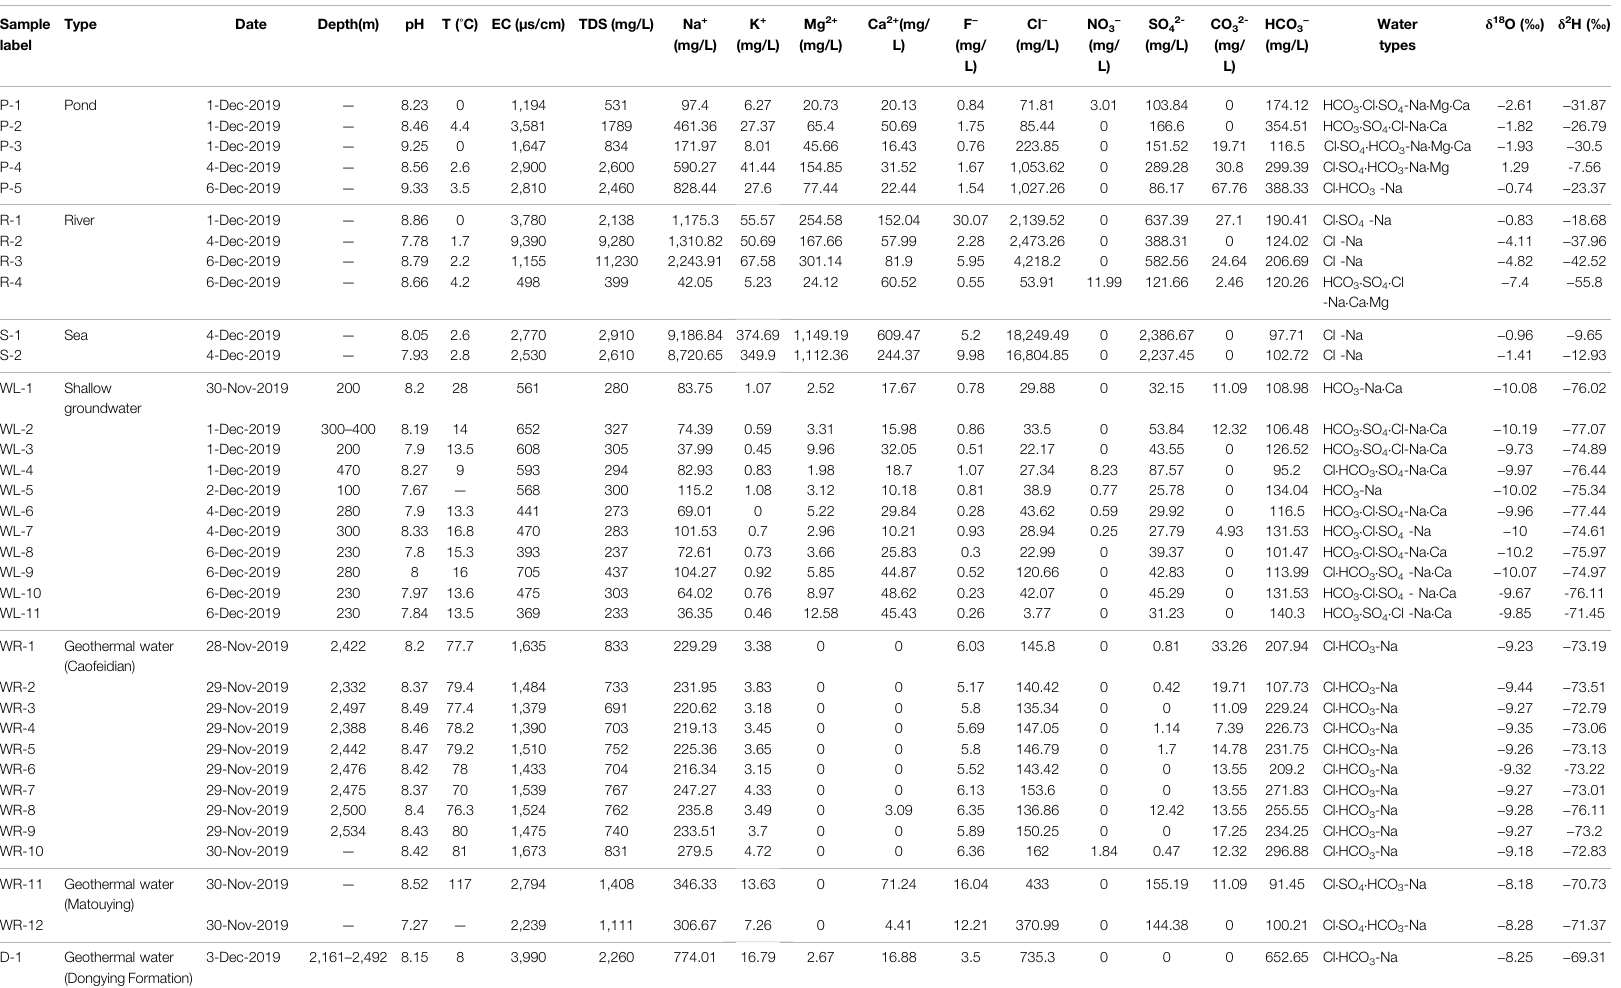
TABLE 1 | Chemical and isotope composition of water samples at Nanpu Sag. Sample